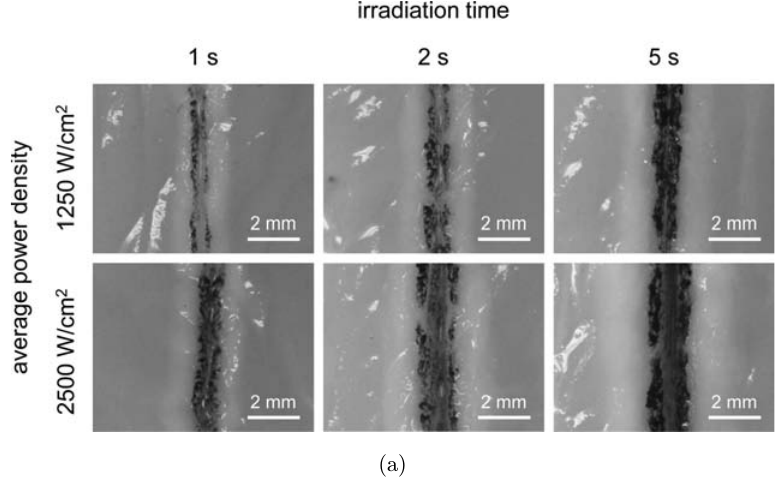
Fig. 4. E®ects of QCL irradiation on chicken breast tissue. (a) Surface view and (b) cross-sectional